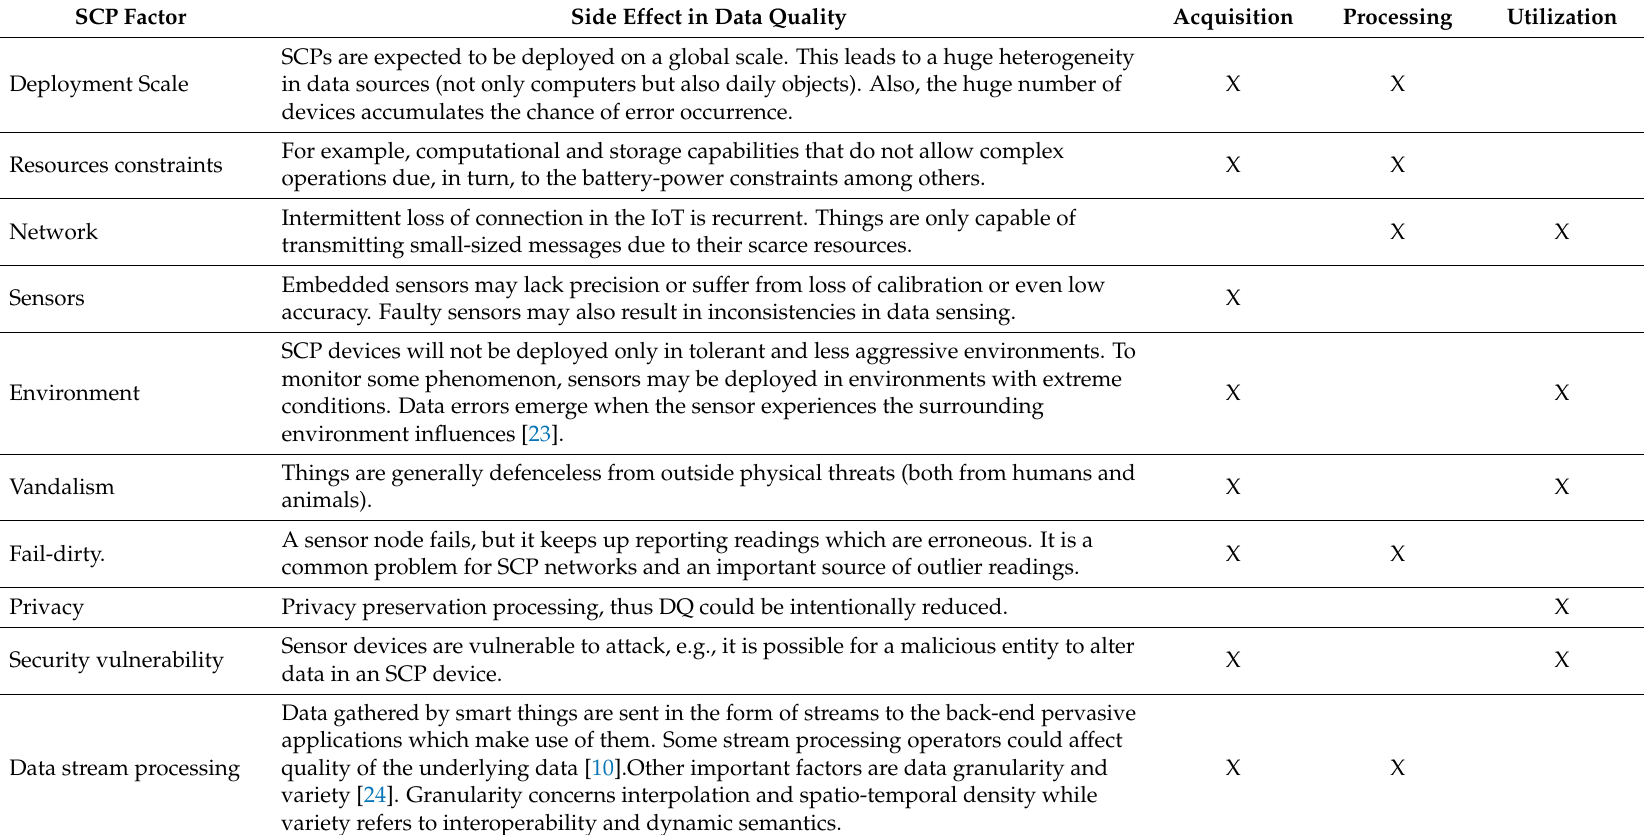
Table 1. SCP factors that can finally affect the levels of DQ according to